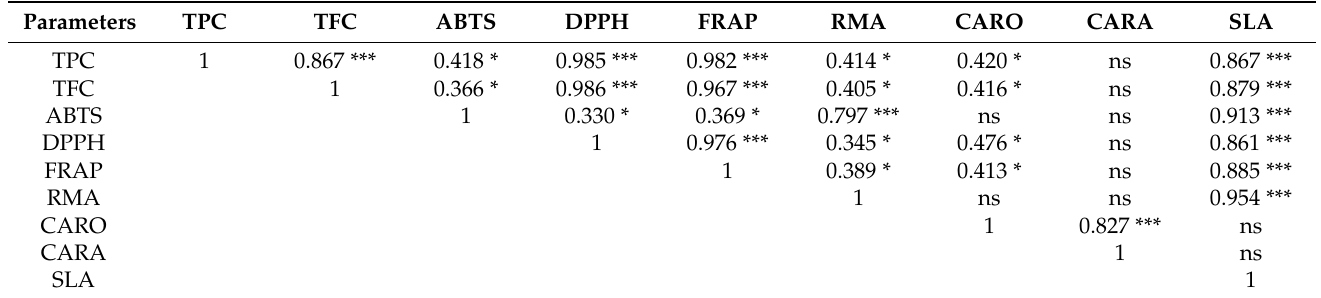
Table 4. Pearson’s correlation coefficients (r) analysis between different assays (TPC, TFC, ABTS, DPPH and FRAP) and main phenolic compounds (RMA, CARO, CARA and